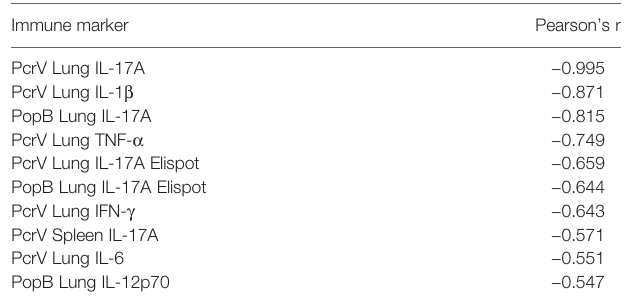
TABLE 1 | Ten pre-challenge immune markers most strongly correlated with post-challenge lung CFUs. Immune marker Pearson ’ s r